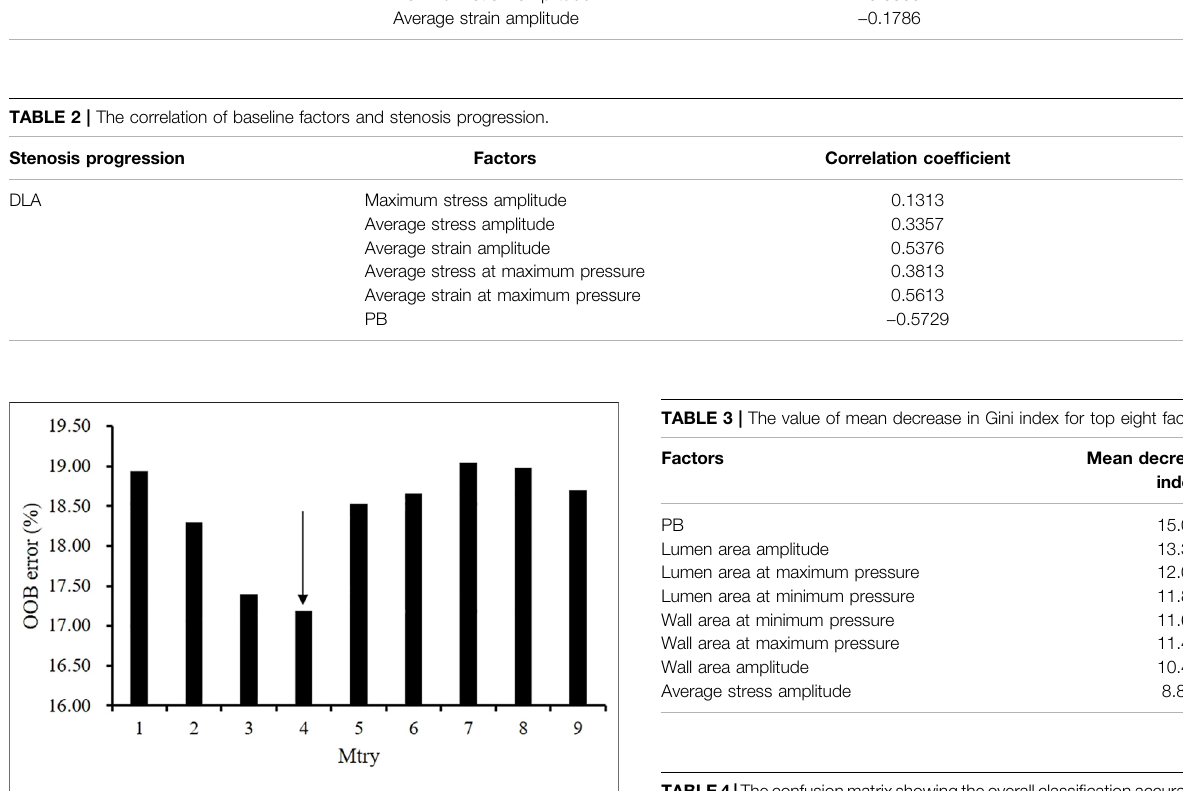
TABLE4| Theconfusionmatrixshowingtheoverallclassi fi cationaccuracyfortwo